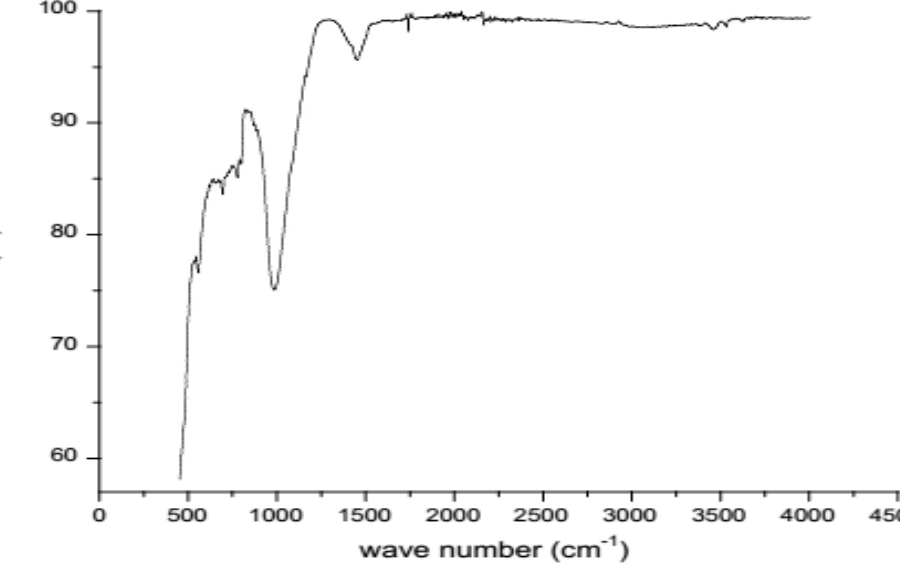
Figure 9. FTIR of the geopolymer obtained at the optimum conditions.